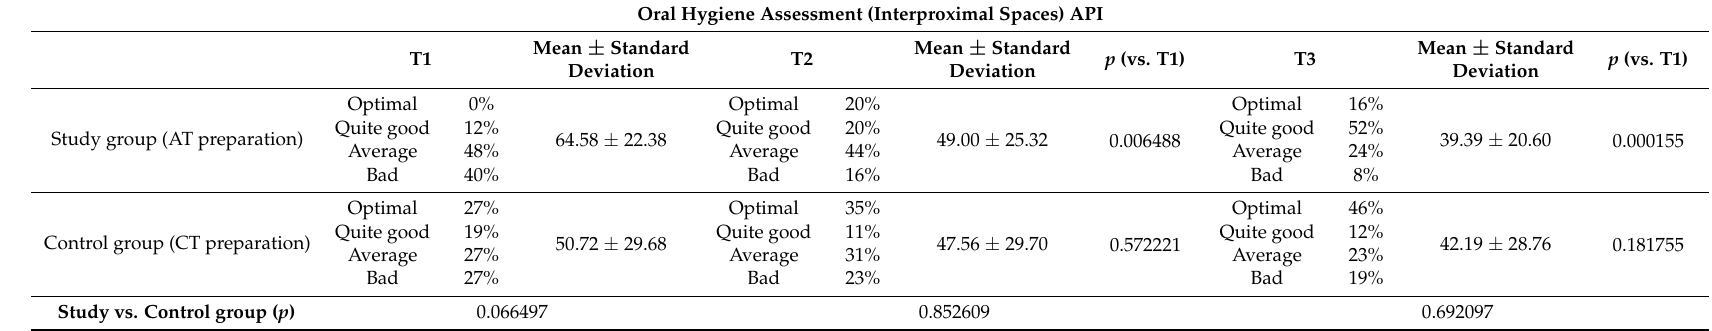
Table 1. Comparison of mean API values with Student’s t -test for dependent and independent samples in study and control groups.